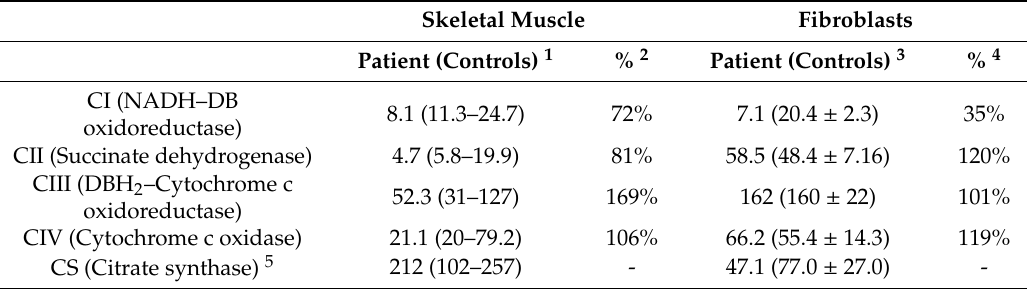
Mitochondrial respiratory chain enzyme activities in skeletal muscle and cultured skin